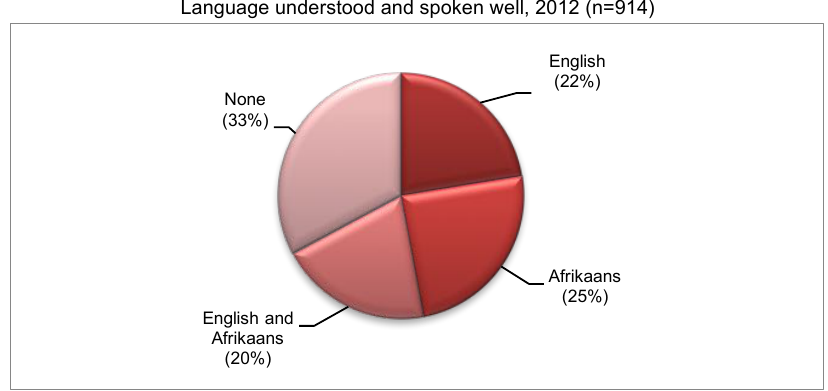
Language understood and spoken well, 2012